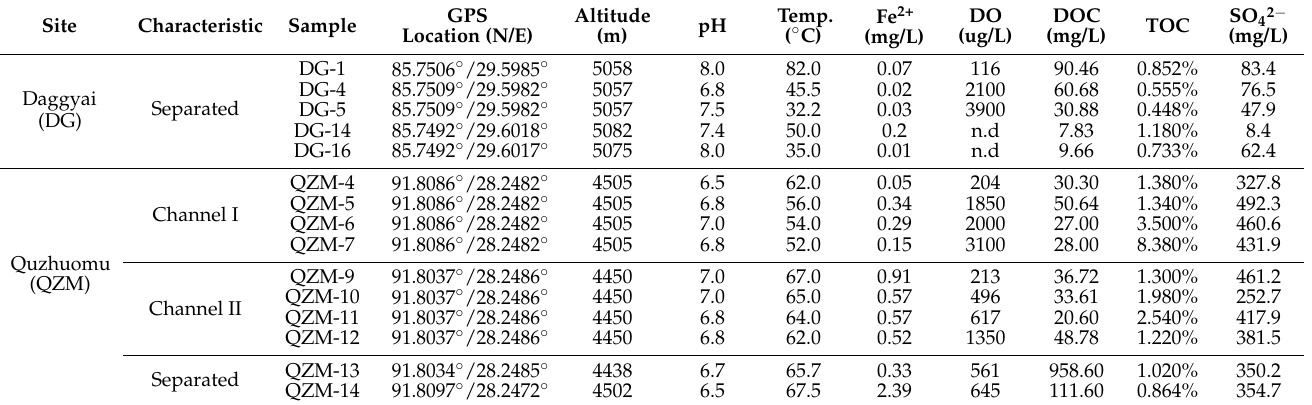
Figure 1. The locations of the Daggyai and Quzhuomu Geothermal Zone in the Tibetan Plateau. Table 1. Geographical and Geochemical Parameters of the Investigated Hot Springs in This Study.